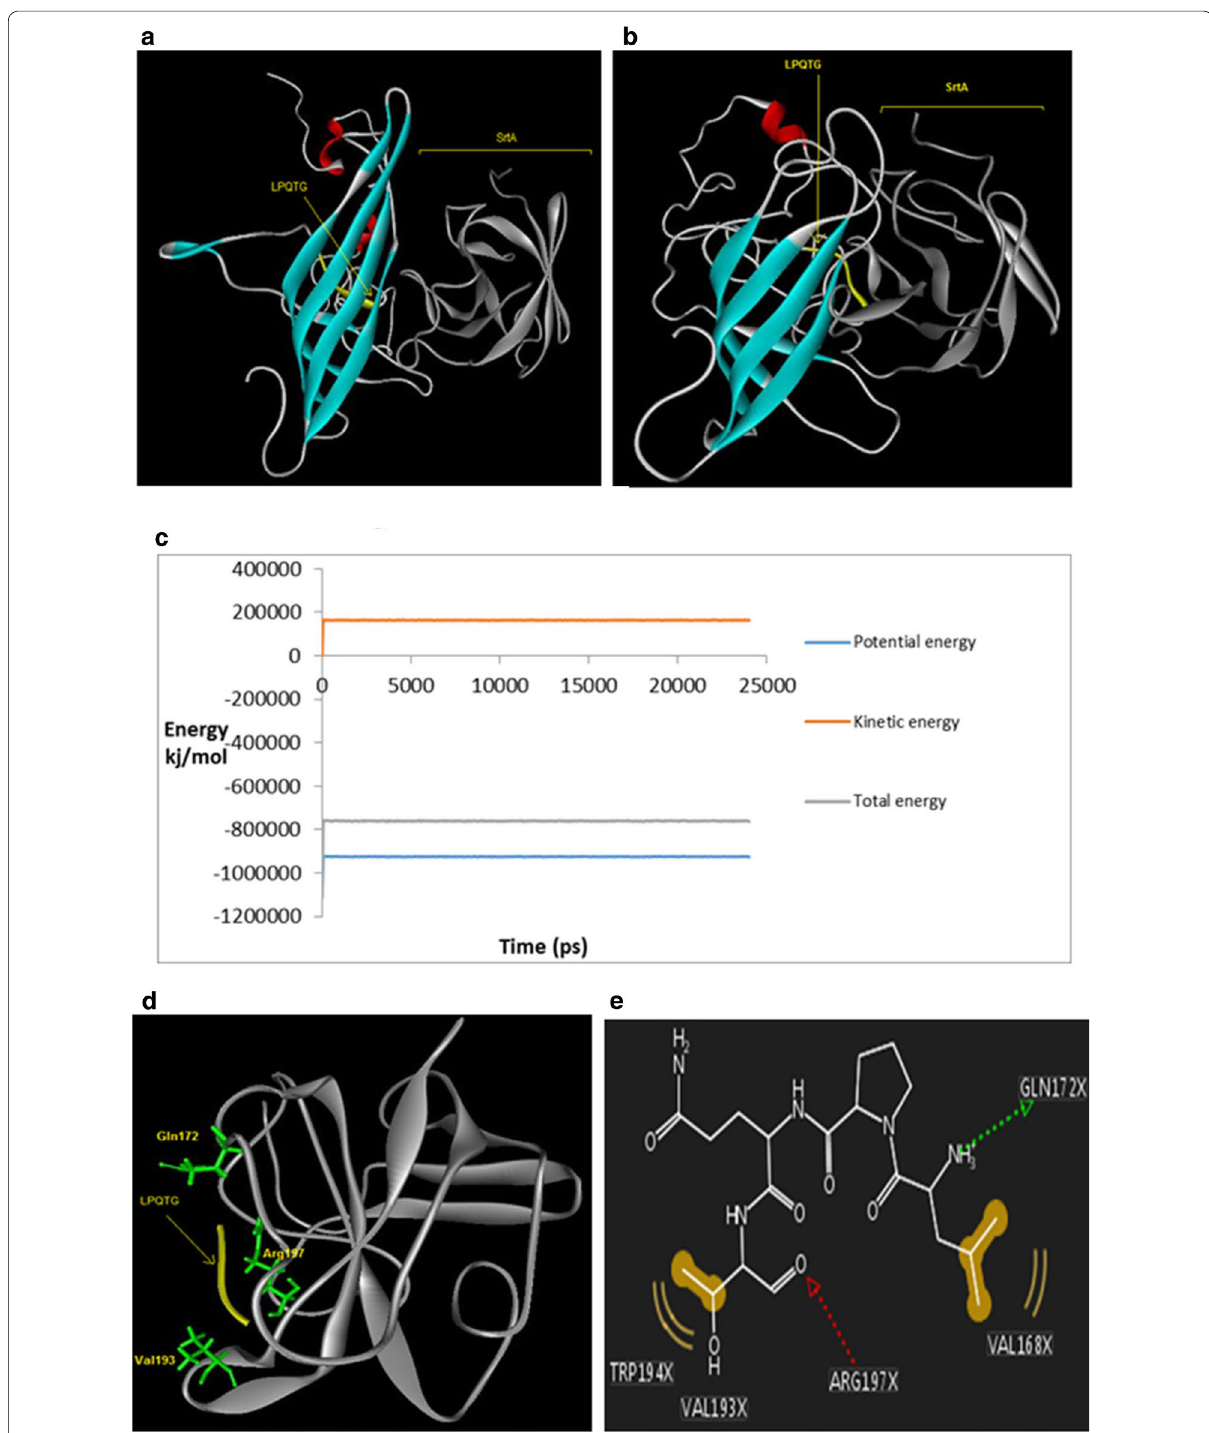
Fig. 3 Molecular docking and molecular dynamic simulations for LO-Mt-Ch complex; a final structure from docking to the srtA, b structure of complex after relaxation showing LPQTG recognized by srtA. c Energy changes during simulation. d The conformation of residues Gln172, Val193 and Arg197 (green) in binding site during interaction with LPQTG (yellow). e 2D interaction diagram for the binding site of srtA with LPQTG. Arg 197 intercts with the bond between Thr and Glys. LO-Mt-Ch complex is gray, srtA is green and LPQTG peptide is yellow with stick